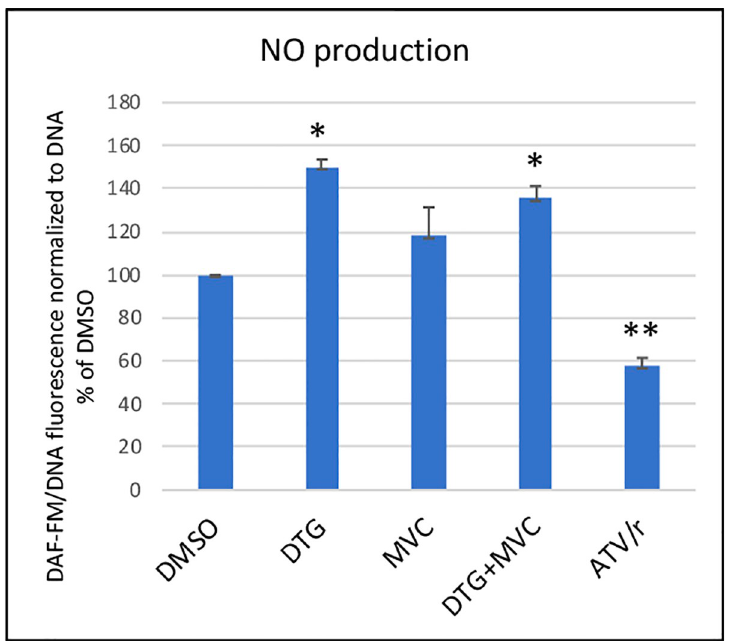
Fig 9. Ability of antiretrovirals to modulate nitric oxide secretion by endothelial cells. NO production was assessed with the cell-permeant NO indicator 4-amino-5-methylamino-2 0 ,7 0 -difluorofluorescein diacetate (DAF-FM) normalized to DNA (Hoechst 33258 fluorescence). The histograms represent the mean+/-SEM value as compared to the DMSO control set at 100% of 3 independent experiments. The comparisons used Welch’s correction of Student T- test. � p < 0.05, �� p < 0.01 versus control